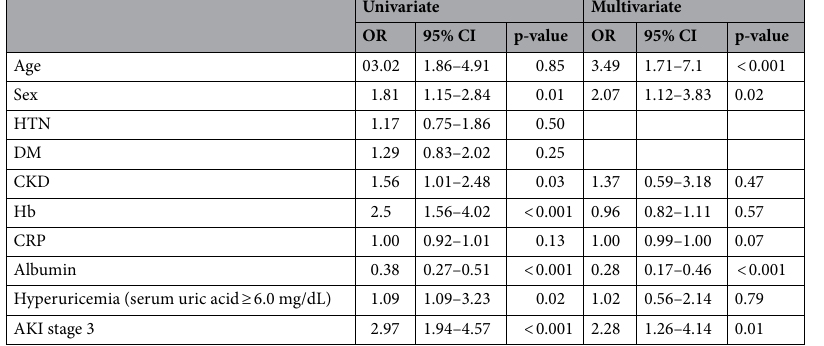
Table 7. Cox regression analysis of factors associates with mortality (non-malignant obstruction). Multivariate Cox regression analysis was conducted after adjusting for sex, age over 65 years, hypertension, diabetes mellitus, ischemic heart disease, underlying liver disease, chronic kidney disease (eGFR ≤ 60 ml/ min/1.73 m 2 ), KDIGO stage 3 AKI, Hb < 11 g/dL, CRP, albumin, and uric acid. HTN hypertension, DM diabetes mellitus, CKD chronic kidney disease, Hb hemoglobin, CRP C-reactive protein.